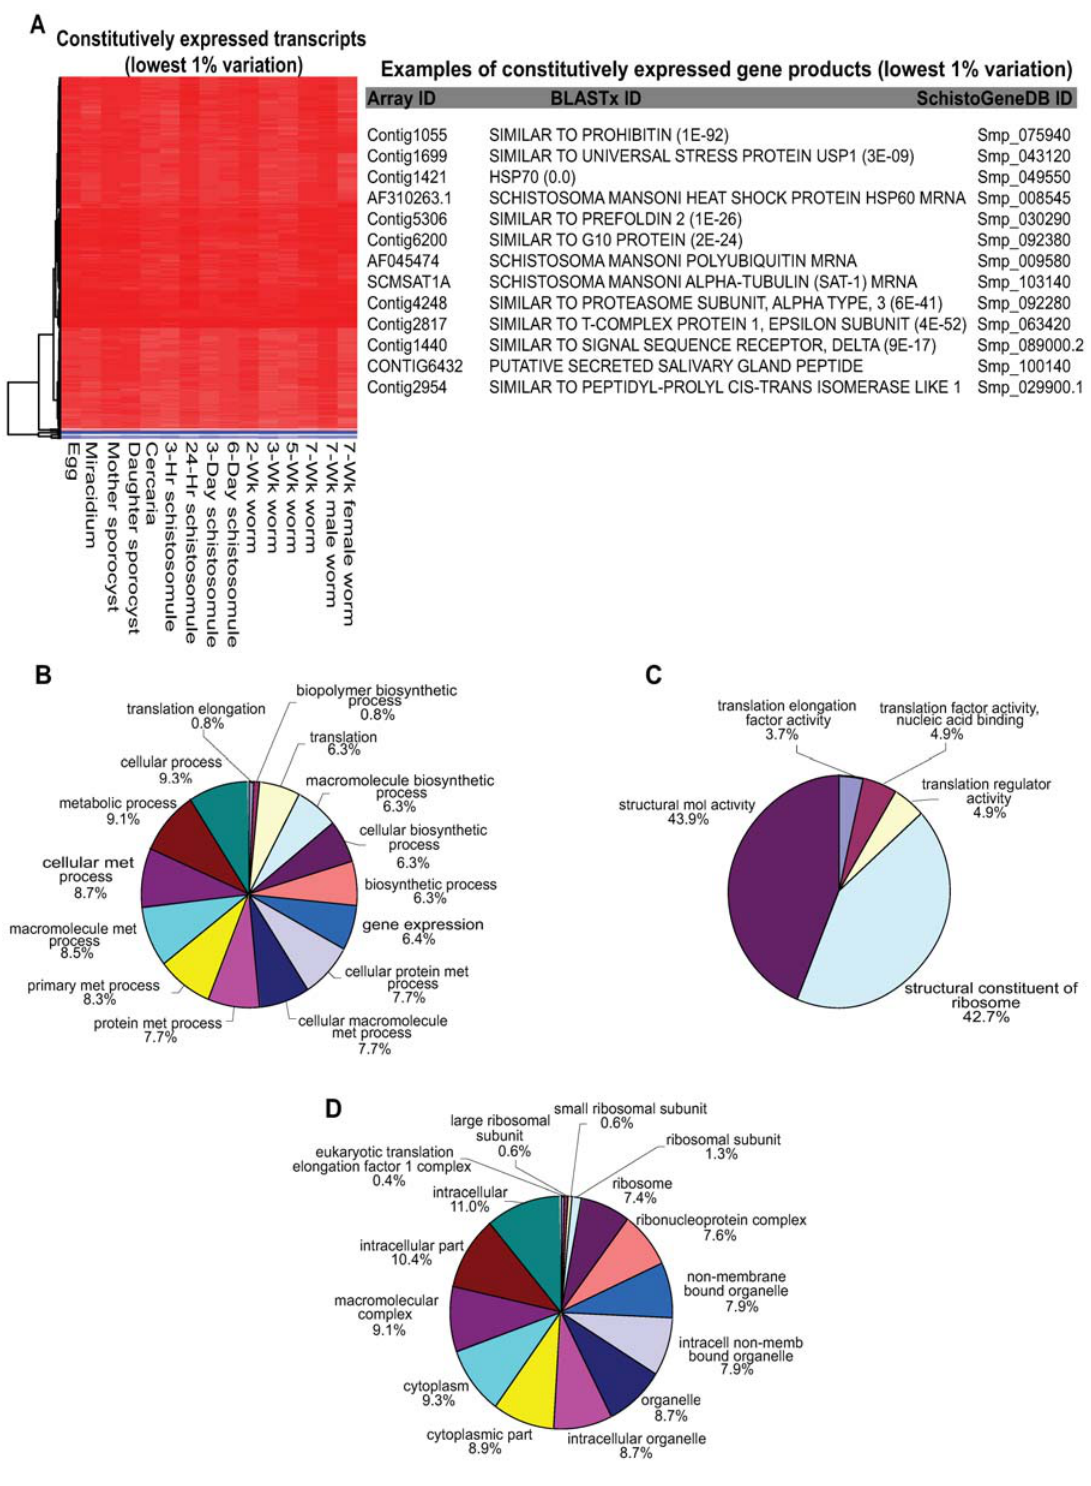
Figure 3. A cohort of constitutively expressed gene products is identified from DNA microarray analysis of the Schistosoma lifecycle. Normalised log 2 AF647 intensity data were used to identify gene products constitutively expressed throughout the schistosome lifecycle (Dataset S5). A) Heatmap of transcripts exhibiting the lowest levels of variation (1% variation across lifecycle). Log 2 intensity values were clustered by Euclidean distance and shown as a dendrogram to the left of the heatmap (red – highly expressed, blue – weakly expressed). Specific examples of gene products constitutively expressed are illustrated (full list included in Dataset S5). B–D) Oligonucleotide sequences (Array ID) mapping to specific S. mansoni gene models (version 4.0) in SchistoGeneDB were analysed for Gene Ontology enrichment ( p , 0.01) using a hypergeometric test. B) Biological process enriched terms; C) Molecular function enriched terms and D) Cellular component enriched terms.